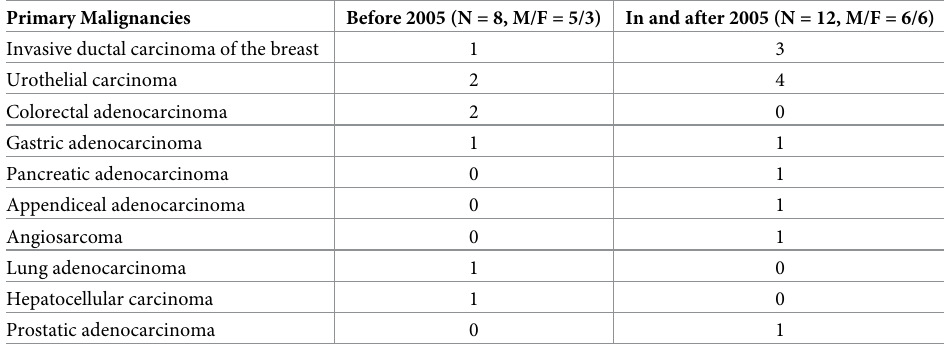
Table 2. Comparison of primary malignancies between before and after 2005.